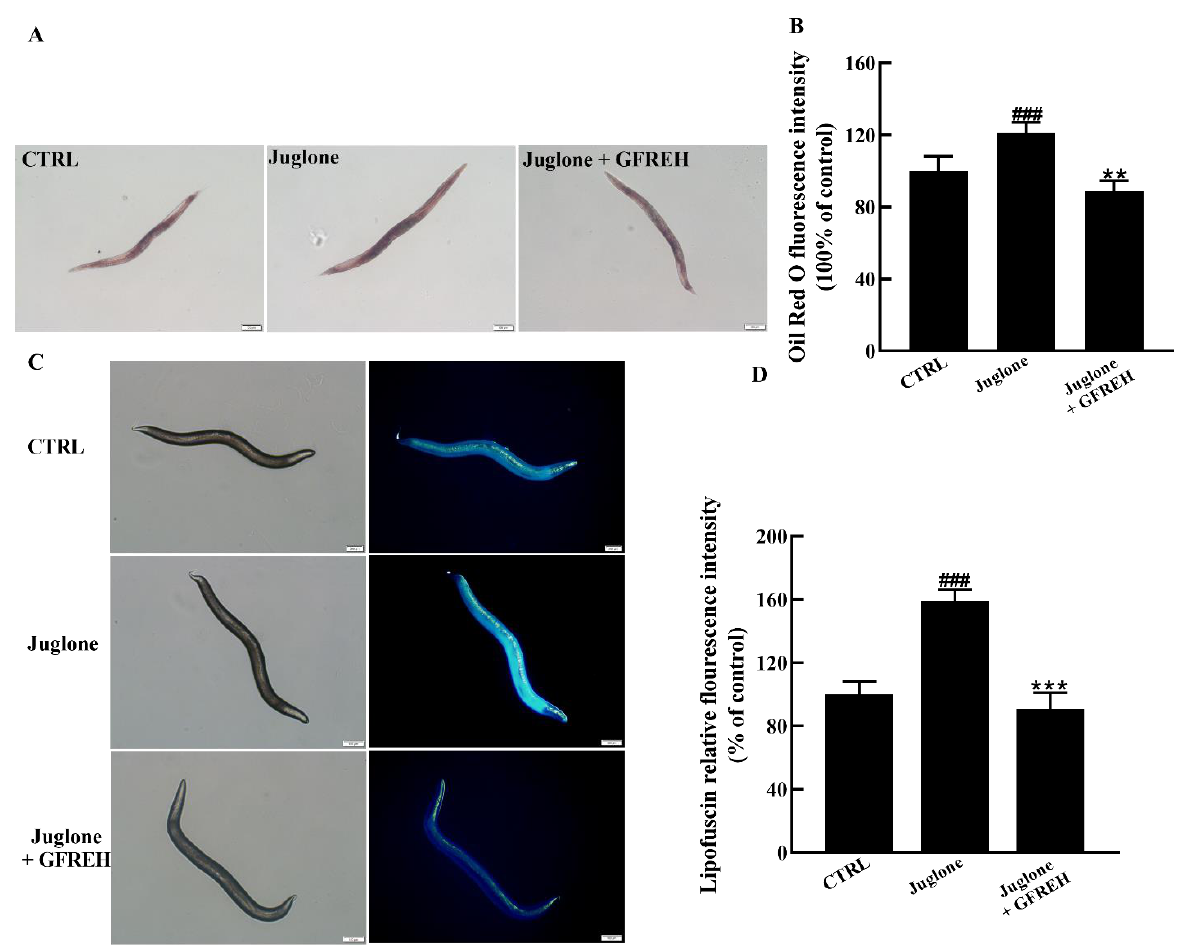
Figure 9. C. elegans N2 pictures imaged by fluorescence microscope. ( A ) Oil red O staining image of lipid accumulation in C. elegans N2 and ( B ) quantitation of the fluorescence by ImageJ software (version: 1.51) (n = 6). ( C ) Autofluorescence image of lipofuscin accumulation in C. elegans N2 and ( D ) quantitation of the fluorescence by ImageJ software (version: 1.51) (n = 6). Scale bar is 100 μm. The data in B and D are presented as the mean value ± SD. ### p < 0.001 vs. CTRL, ** p < 0.01 and *** p < 0.001 vs. the Juglone group.